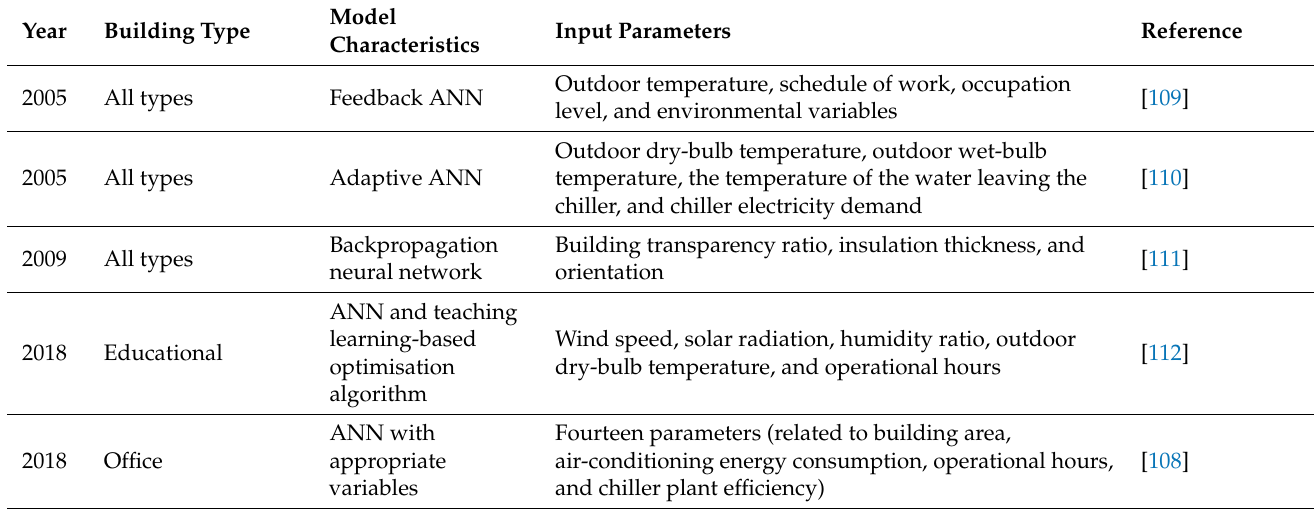
Table 4. Studies related to ANN models.